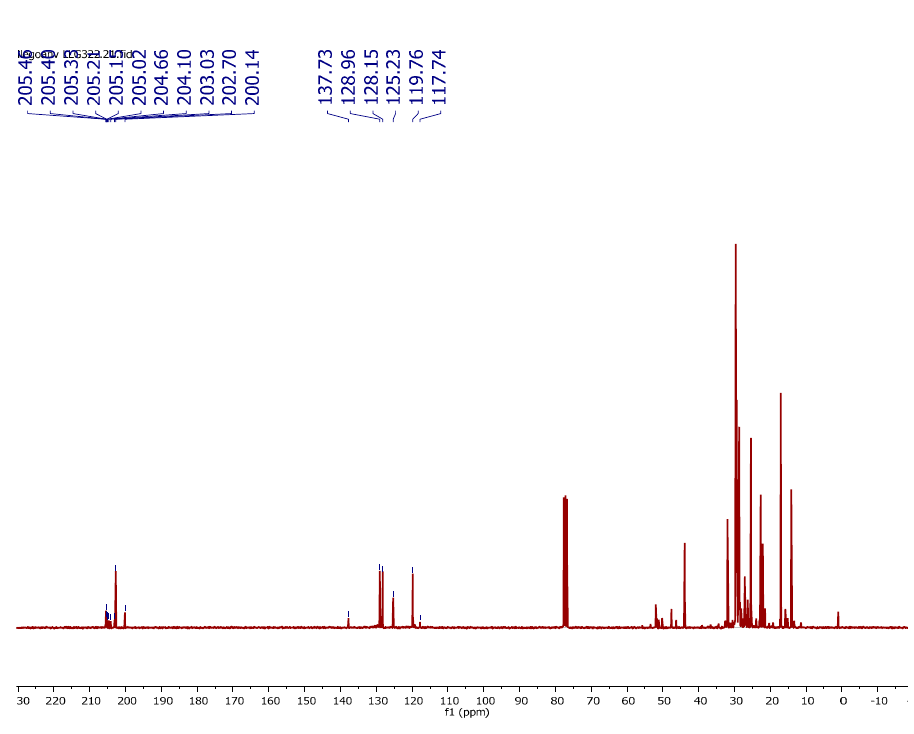
Figure A3. Detail of the aldehyde region of the 1 H NMR spectrum (400 MHz, CDCl 3 , 298 K) of a typical final mixture in the hydroformylation of oleonitrile (Table 2, entry 8).